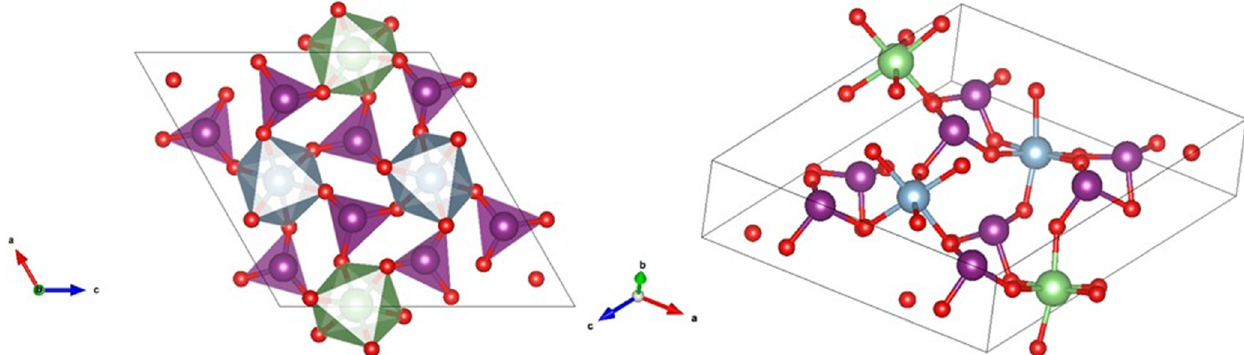
Figure 4. Schematic representation of the crystal structure of LiAl(IO 3 ) 4 from different views. The AlO 6 and LiO 6 octahedra are shown (in cyan and green, respectively) as well as the IO 3 triangular pyramids (in violet).